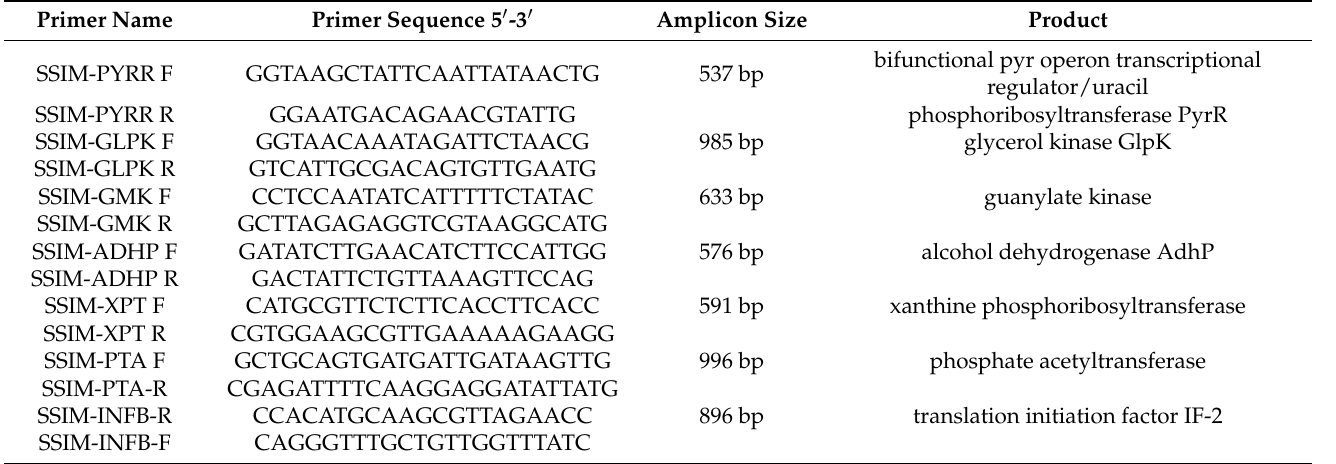
Table 2. Summary of primers used for MLST of Staphylococcus simulans